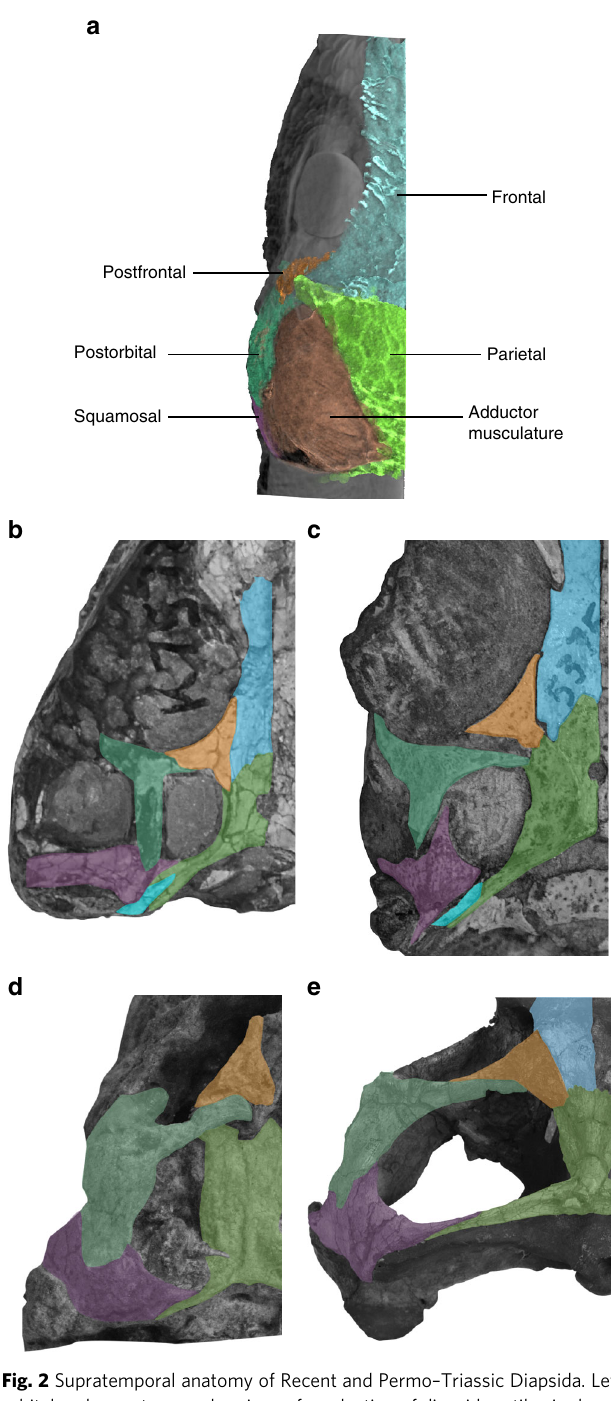
Fig. 2 Supratemporal anatomy of Recent and Permo – Triassic Diapsida. Left orbital and supratemporal regions of a selection of diapsid reptiles in dorsal view. a Three-dimensional reconstruction of contrast-stained specimen of Anolis sagrei , illustrating the direct correlation between the osseus supratemporal fossa and the transverse breadth of the dorsal portion of the adductor muscle mass in diapsids. Photographs of the fossil skulls of b Tropidostoma Zone Youngina (SAM-PK 7573), c Prolacerta broomi